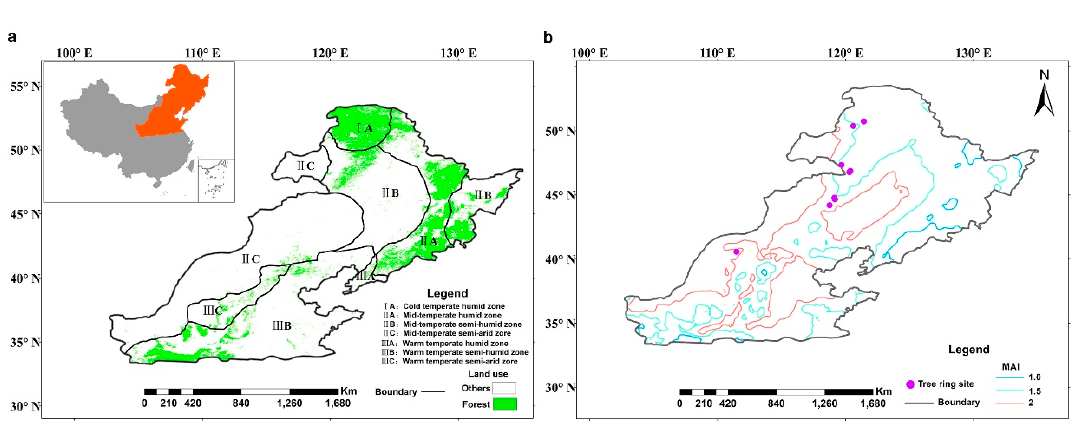
Figure 1. Spatial distribution of forests and seven major climatic zones ( a ), and contours of multi-year average dryness index (MAI) and the locations of eight tree-ring chronology sites ( b ) over northeastern China.